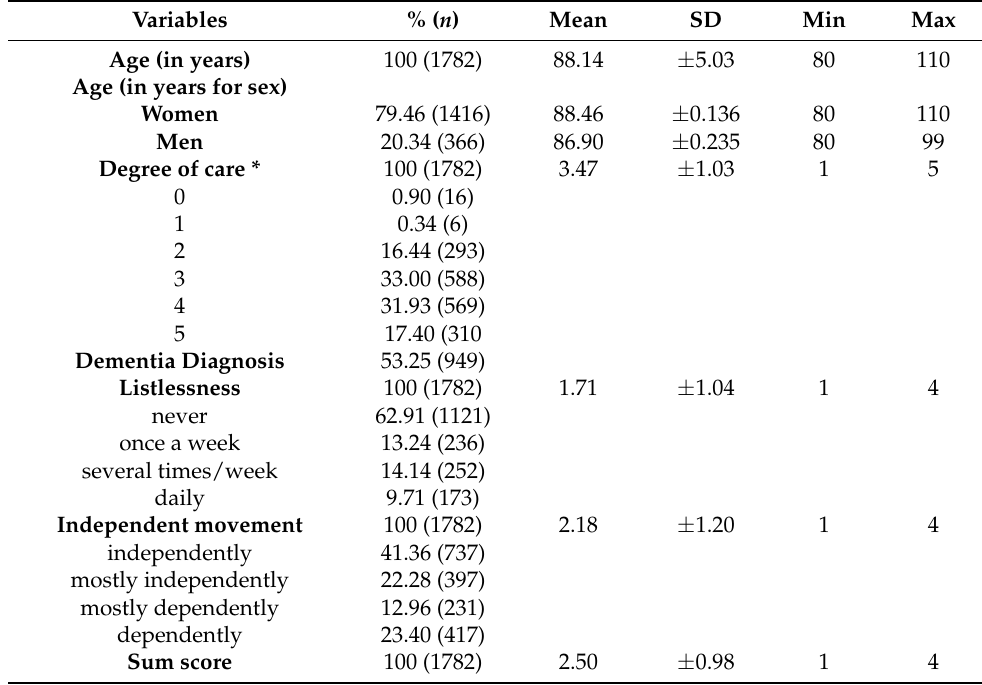
Table 1. Descriptive characteristics at the residents’ level.